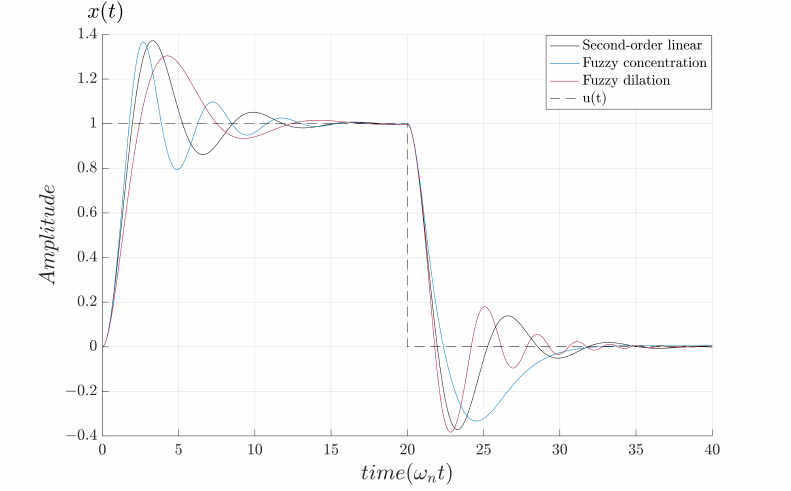
Figure 15. Step response, with normalised time ω n t , for K = 1 and ζ =